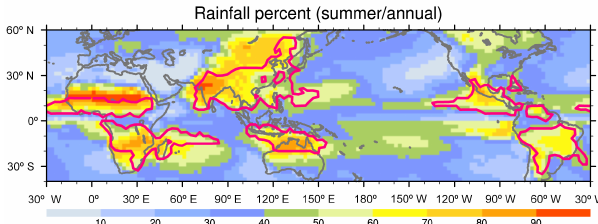
Figure 2. Climatological percentage of summertime rainfall amount (JJAS in the Northern Hemisphere and DJFM in the South- ern Hemisphere) in annual accumulation. Monsoon region is circled by red curves. GPCP data are used and the time covers 1979–2014.